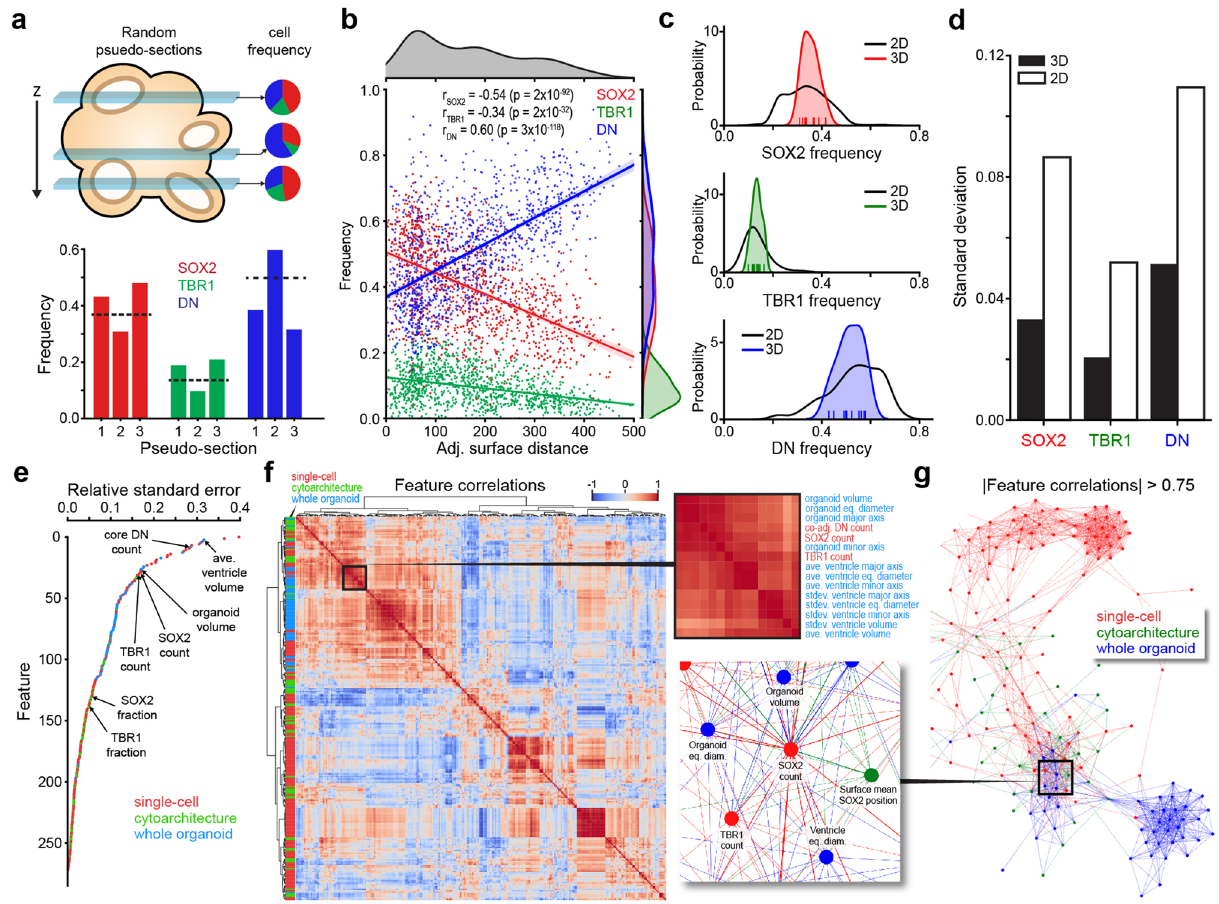
Figure 4. Whole-organoid analysis for unbiased quantitative studies. ( a ) Scheme (top) and analysis of three different 100 µm pseudo-sections from a 3D dataset. Pie charts (right) show the variable depth-dependent cell frequency for individual slices. Bottom shows the estimated cell frequency for each cell type with the actual whole-organoid frequency (dotted line). ( b ) Analysis of cell frequencies for 1187 segmented ventricles pooled from 12 day 35 organoids. Cell frequency for each ventricle was determined by combining the counts of cells detected in all “virtual cortical columns” used for cytoarchitecture analysis. ( c ) Comparison of pseudo-slice heterogeneity with biological inter-organoid variability. Each histogram shows the distribution of 10,000 pseudo-sections. 100 µm thick for 12 organoids (black) versus the distribution of whole-organoid frequency in different replicates (colored histogram, ticks show independent organoid values). ( d ) Comparison of cell frequency standard deviation for the pseudo-sections sampling variability (2D) versus whole-organoid biological variability (3D) in 12 organoids. ( e ) Comparison of the relative standard error for 276 multiscale features in 12 ‘day 35’ organoid replicates where each dot is colored based on to the scale of its analysis. ( f ) Heat map of Pearson’s correlation coefficient investigating the relationship between the 276 multiscale features and their variation in ‘day 35’ organoid replicates. Right, shows the cropped region where we see a combination of single-cell (red) and whole-organoid (blue) features where r > 0.88. ( g ) Network of feature correlation when the absolute Pearson’s correlation coefficient is > 0.75. Cropped region shows the same multiscale correlation as the heat map in panel F. The SOX2 cell count and organoid volume were the most central nodes in this cluster, both having a degree of